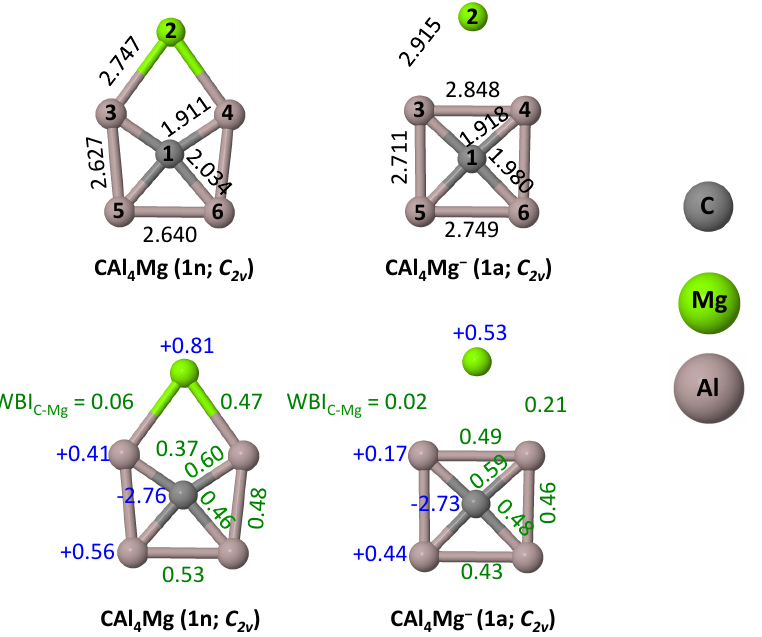
− ( 1a ). Bond lengths are given in 1n ) and CAl 4 Mg ( 4 Mg